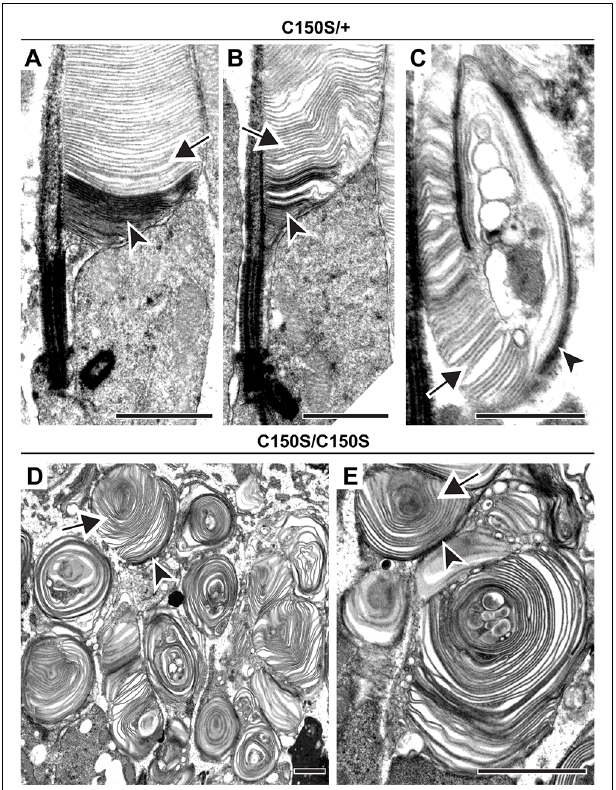
FIGURE 3 | Expression of C150S PRPH2 disrupts outer segment structure without preventing disc enclosure. (A–C) TEM of photoreceptor outer segments of 30-day old heterozygous C150S (C150S/+) mice stained with tannic acid. (D,E) TEM of photoreceptor outer segments of 16-day old C150S homozygous (C150S/C150S) mice stained with tannic acid. For each genotype, over 100 different outer segments from two mice were analyzed. For all images, arrowheads mark darkly stained open discs while arrows mark lightly stained enclosed discs. Scale bars are 1 µ